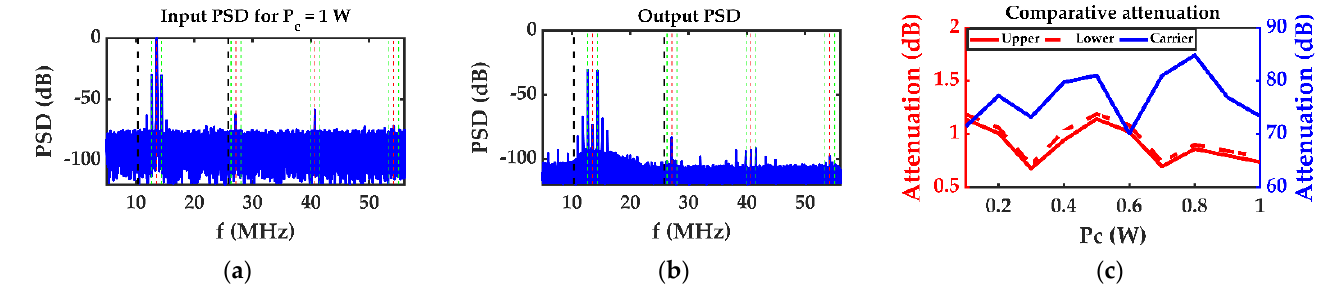
Figure 9. Power spectral densities of ( a ) input signal to port 1 of MI single-notch directional filter; ( b ) output signal at port 2 normalised by the input carrier power P c . Dashed lines: filter bandwidth; red: harmonics at multiples of carrier frequencies; green: harmonics at message sidebands. ( c ) Attenuation of sidebands and carrier.